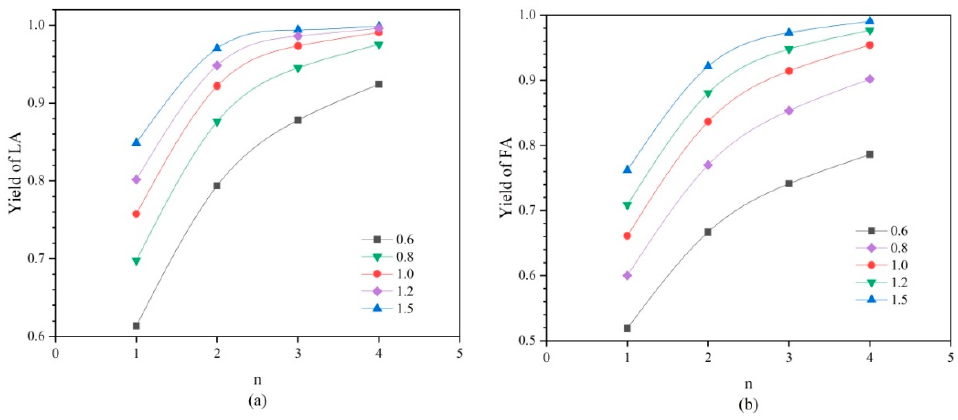
Figure 17. Influence of n-octanol dosage on yields of ( a ) LA and ( b ) FA.